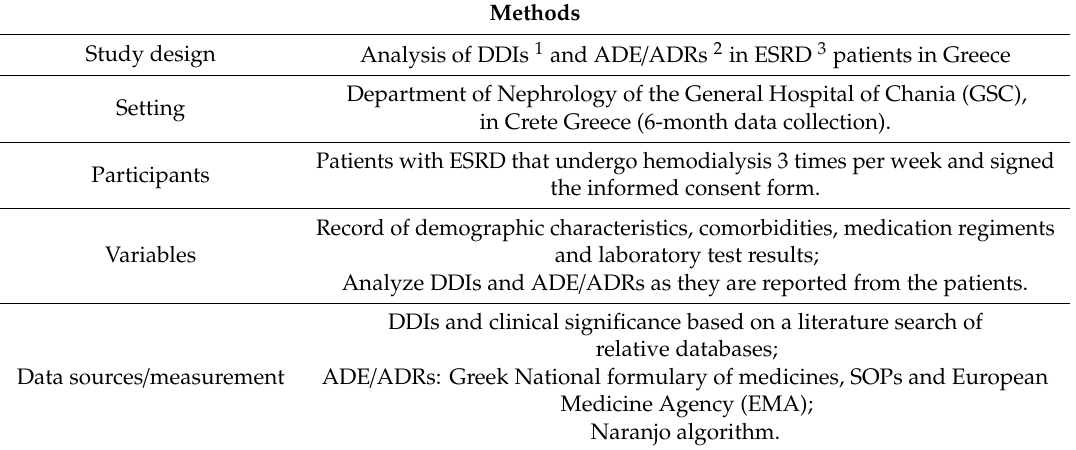
Table 1. Strengthening the Reporting of Observational Studies in Epidemiology (STROBE) information for the study regarding methods and results.